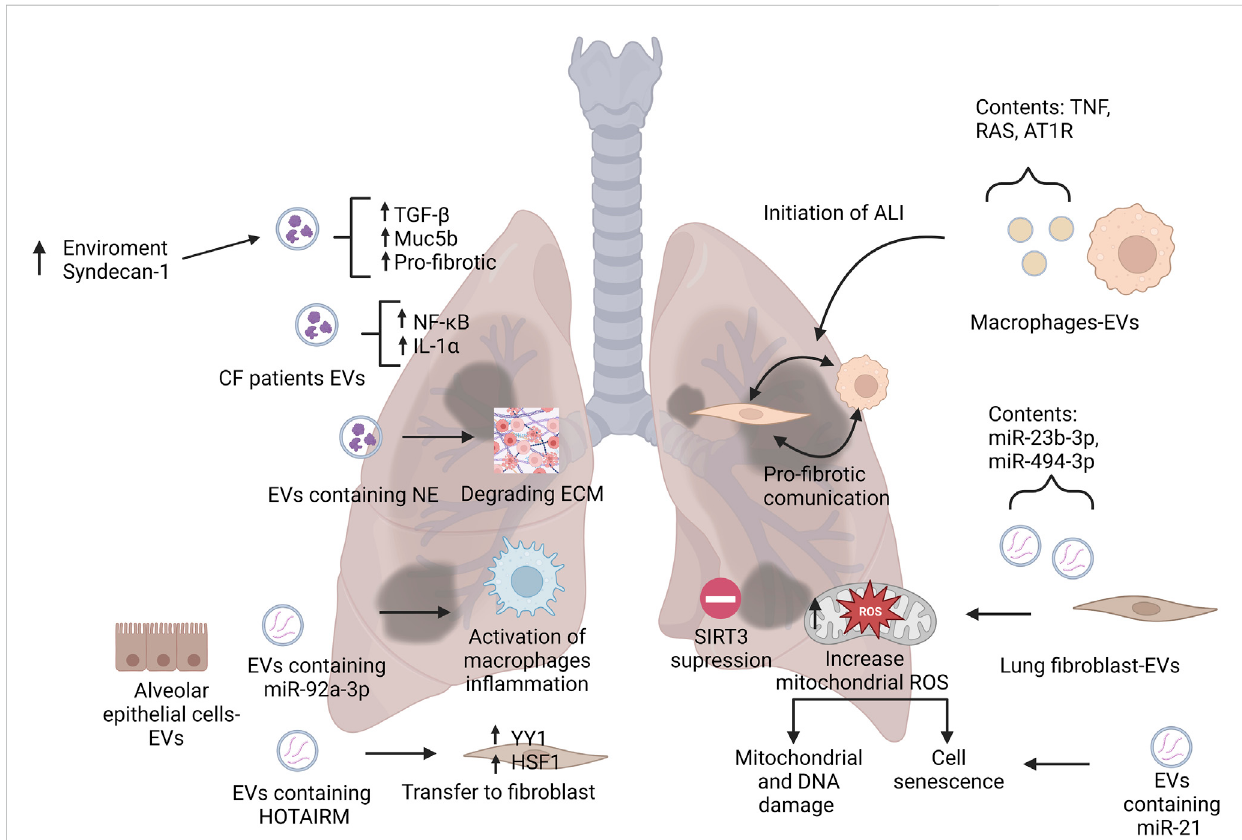
Representation of EVs roles in pathogenesis of pulmonary diseases. This fi gure illustrates the main roles of EVs on the initiation and contribution to pulmonary disease by modulating the environment and nearby cells. Abbreviations: CF, cystic fi brosis; NE, neutrophil elastase; TGF- β , tumor necrosis factorbeta;IL- α ,interleukinalpha;NF- κ B,nuclearfactorkappaB;ECM,extracellularmatrix;HSF1,heatshockfactor1;ALI,acutelunginjury;SIRT3,sirtuin 3; TNF, tumor necrosis factor; RAS, renin-angiotensin system; AT1R, angiotensin II type 1 receptor; ROS, reactive oxygen species. Created with